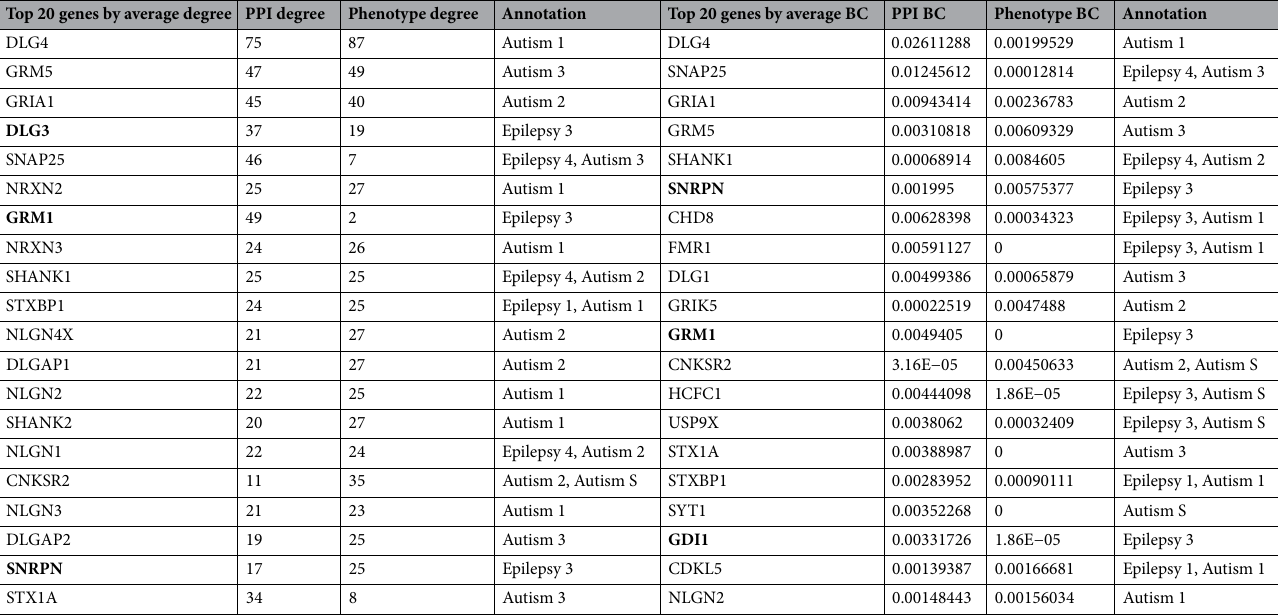
Table 3. Highest centrality genes in module 6. The top 20 genes in module 6 are listed and ranked by average degree and average betweenness centrality (BC). Genes that are epilepsy-specific are bolded since module 6 is an autism-focused